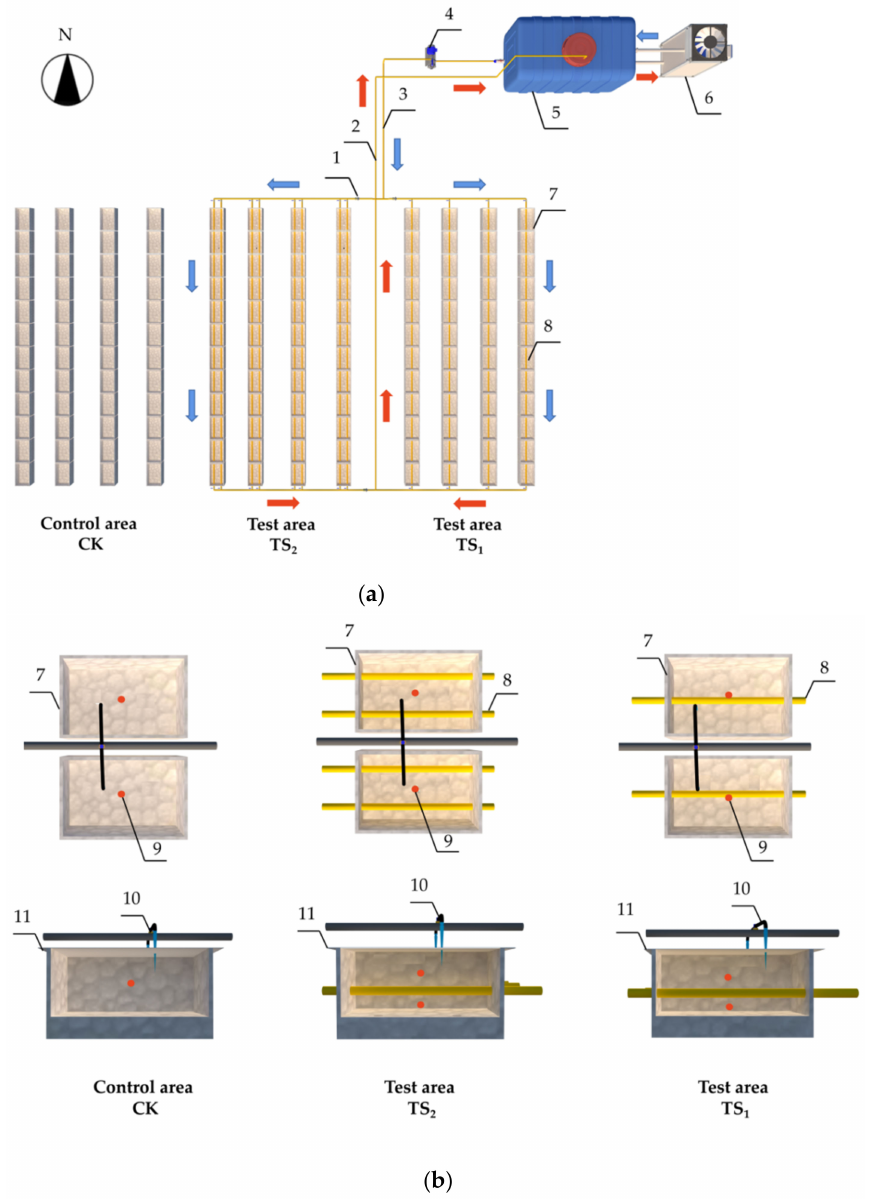
Figure 1. Schematic diagram of WCTRZSCS. ( a ) Integrated schematic diagram; ( b ) Local schematic diagram: 1 is a solenoid valve, 2 is water return pipe, 3 is water supply pipe, 4 is a water pump, 5 is a water storage tank, 6 is a chiller, 7 is a foam box, 8 is a polyethylene raised-temperature-resistance (PE-RT) pipe, 9 is a substrate temperature sensor, 10 is an arrow dripper, and 11 is transparent plastic film. Blue arrow and red arrow represent the inflow direction and return direction